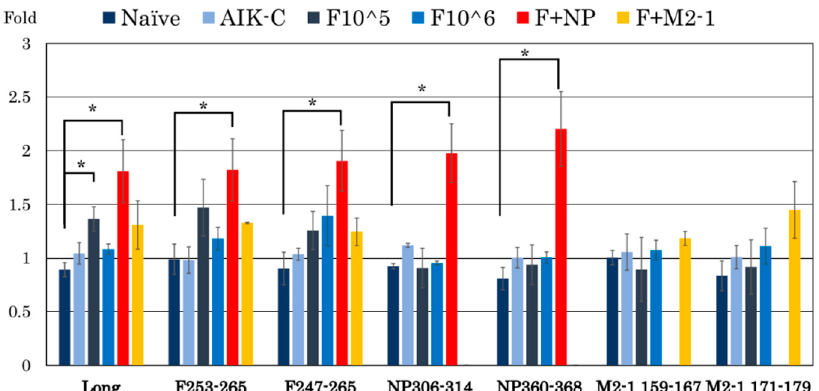
Figure 4. The proportion of CD8 + /IFN- γ + cells in spleen cells obtained four days after the RSV challenge (Day 88), stimulated with UV-inactivated RSV Long strain, F, NP, and M2-1 peptides. Spleen cells were obtained after the RSV challenge and analyzed for IFN- γ production by CD8 + cells. The bar represents the mean of 3~4 rats per group ± SEM. (* p < 0.05).